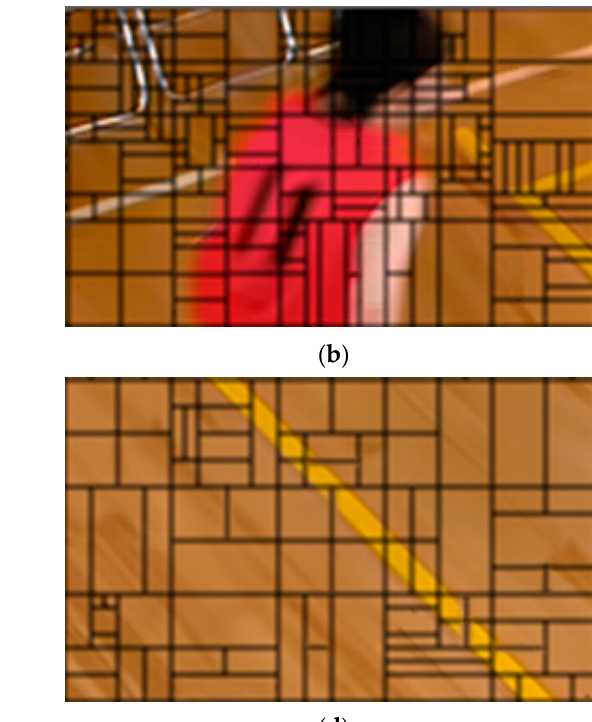
Figure 7. Histogram of experimental comparison.